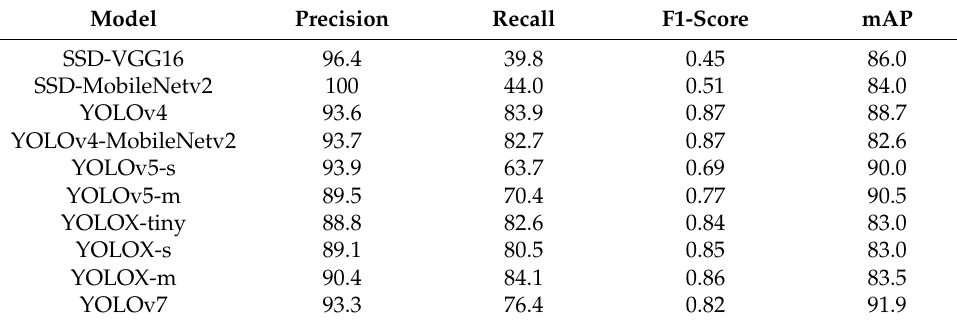
Table 2. The results of different object detection algorithms.